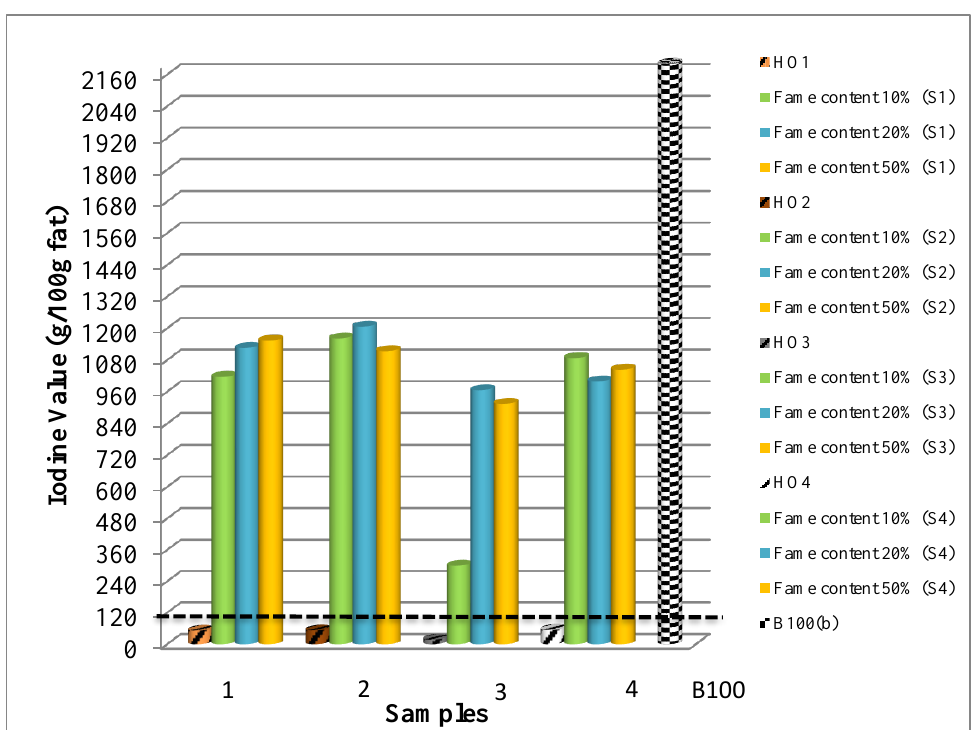
Figure 5. Iodine value (IV) of oil samples.